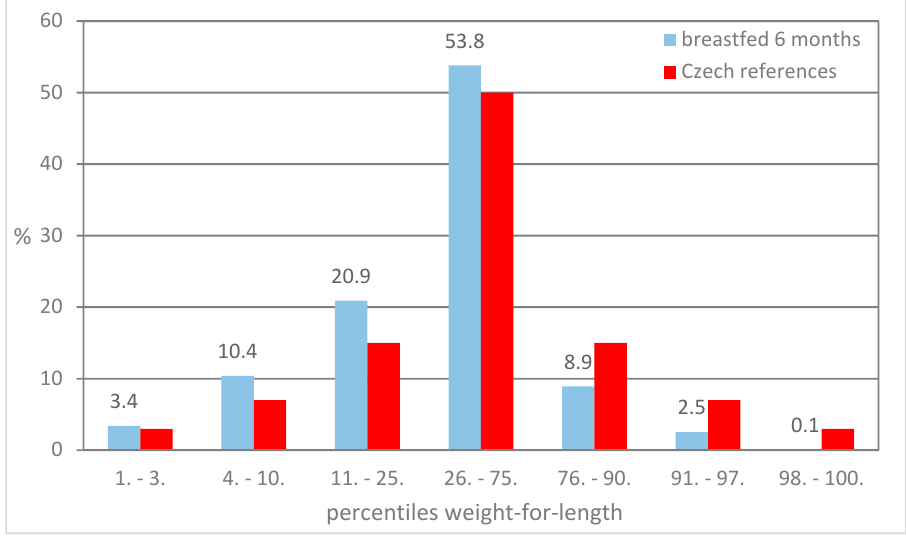
Figure 2. Proportion of children in the percentile categories of weight-for-length at 12 months.